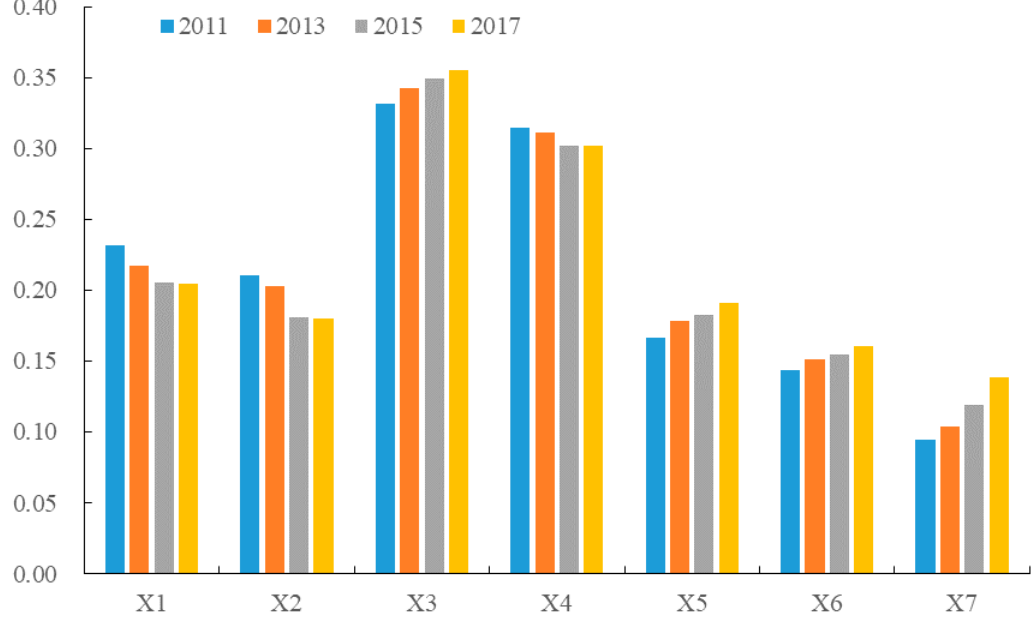
Figure 5. The results of influencing factors of rural LRAE in Fang County from 2011 to 2017.